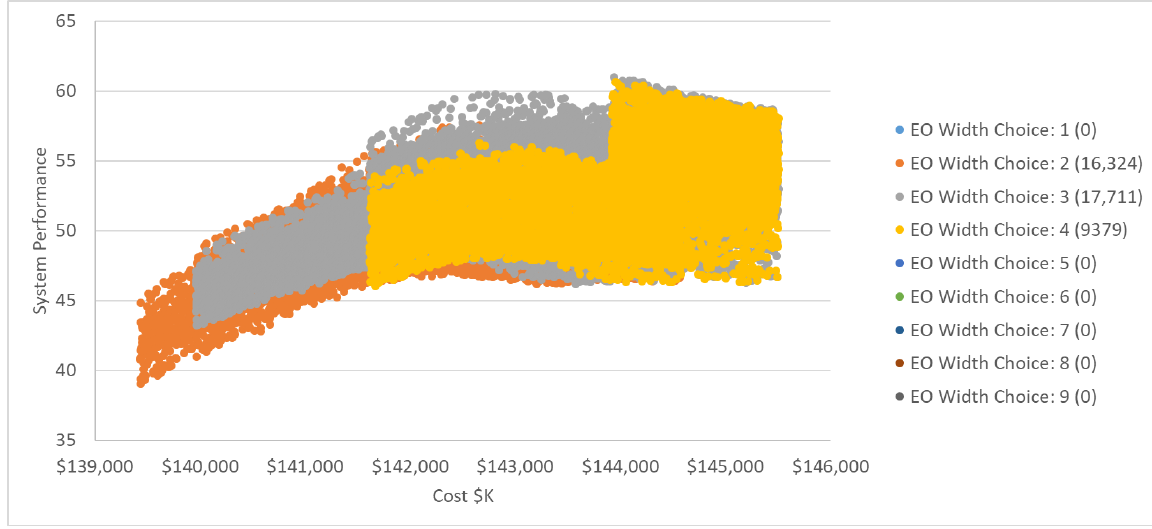
Figure 15. Final UAV Tradespace with Electro-Optical Sensor Width Choice as Set Driver. Table 3. Summary of Tradespace Refinement Results for All Design Teams.